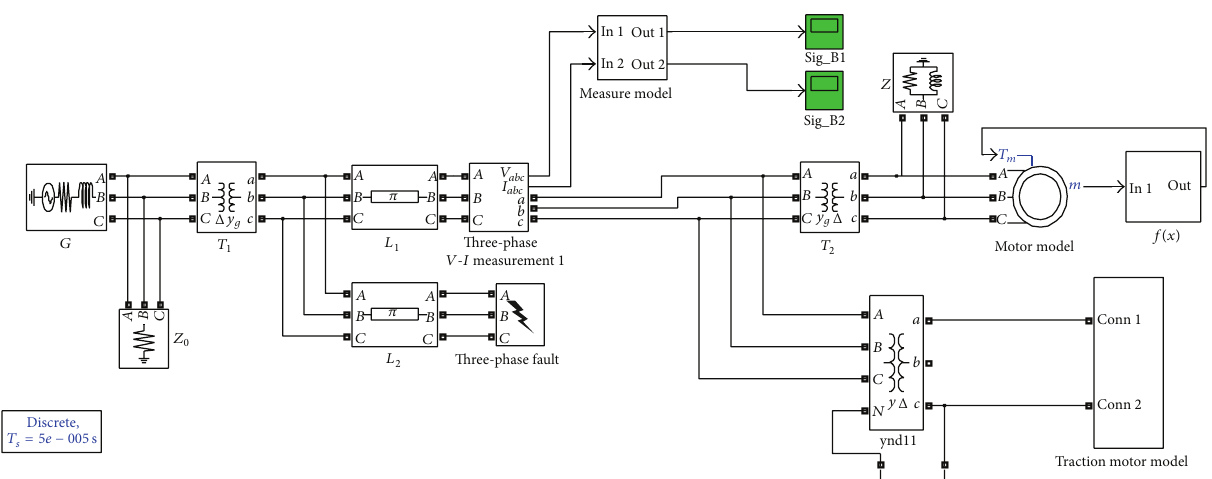
Figure 6: Load modeling based on AHP simulation system in Matlab/Simulink.